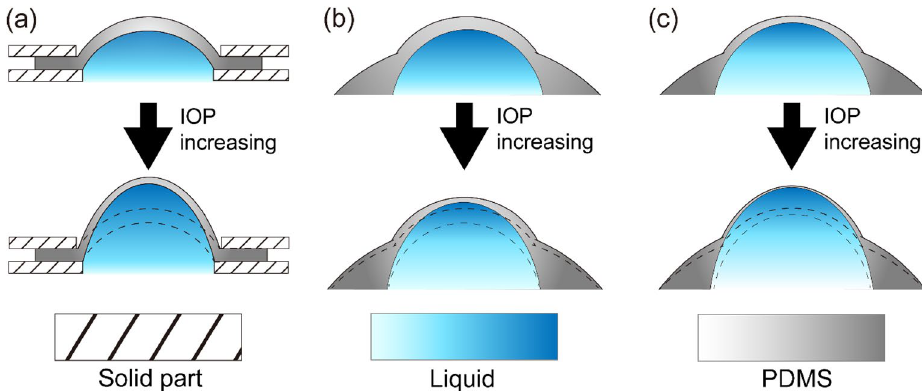
Figure 5. Illustration describing the structural deformation caused by increasing intraocular pressure for the cornea eyeball phantom ( a ) and the full eyeball phantom with thick ( b ) and thin ( c ) the central cornea thickness under zero